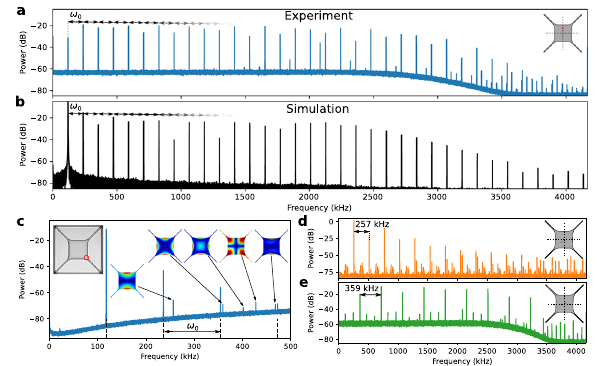
Fig. 2 | Overtone frequency combs. a Measured spectrum of a mechanical fre- quency comb of the fundamental mode ( ω 0 =2 π ×118.049kHz) of a suspended Si 3 N 4 membrane,consistingof35peaksspacedby ω 0 .Theovertonesarespectrally fl at until ~2200kHz, after which their amplitude drops exponentially. Inset shows the location of the laser spot to generate and read out the comb. The additional peak around 2083kHz is from a different mechanical mode, see Supplementary section F. b Simulated overtone comb spectrum, by integrating Eq. (1), matching the measurement of a . c Simultaneous measurement of fundamental-mode fre- quency comb ( fi rst four teeth) and higher-order mechanical modes of the mem- brane.Insets:laserspotposition(left)andmodeshapes. d , e Mechanicalfrequency combs of the second mode(257kHz) and third modes (359kHz). Difference in the noise fl oorisduetodifferentdecodersusedduetooverloading.The257kHzmode has a near-degeneracy, so the comb spectrum is less clean. Insets show the laser position to drive and read out the different